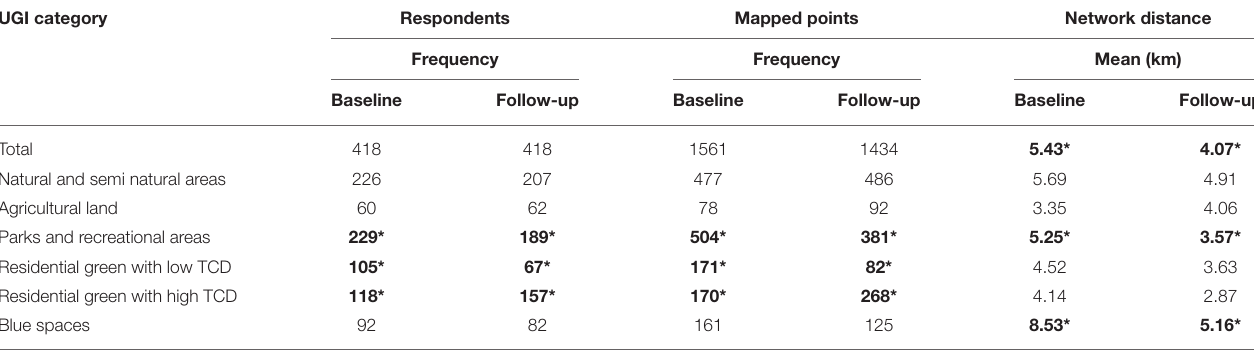
Residential green with low